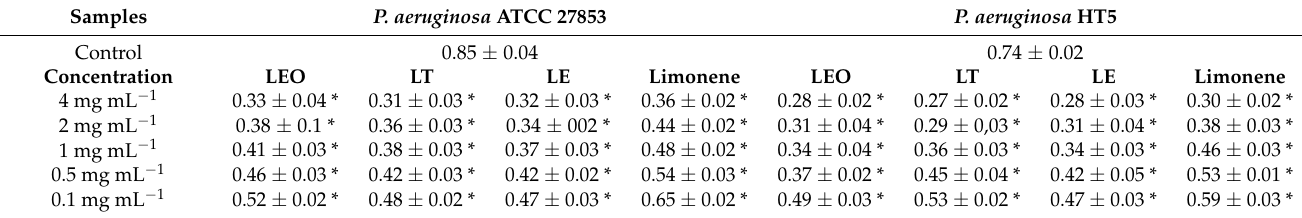
Table 2. Pyocyanin pigment production from Pseudomonas aeruginosa strains.